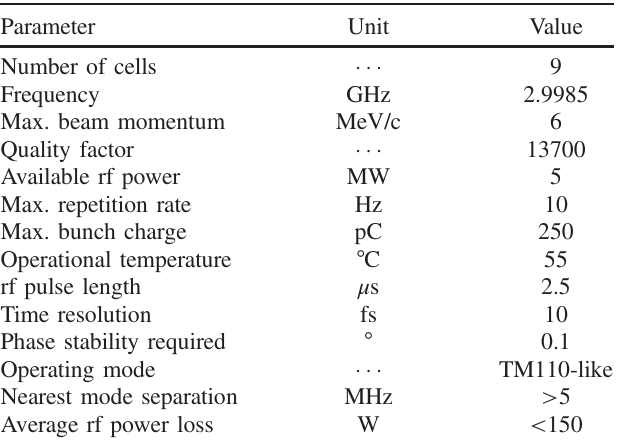
TABLE VI. Operational parameters of the TDC.